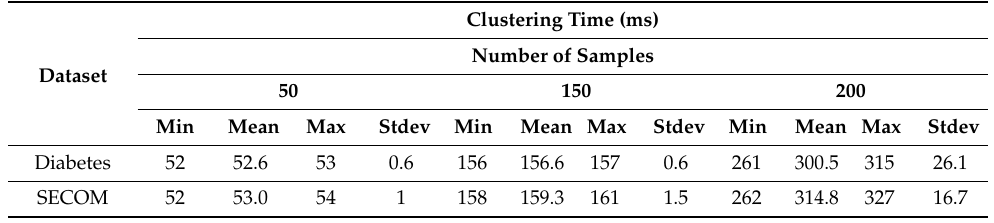
Table 4. k-means clustering time performance on the edge device with confidence algorithm enabled.